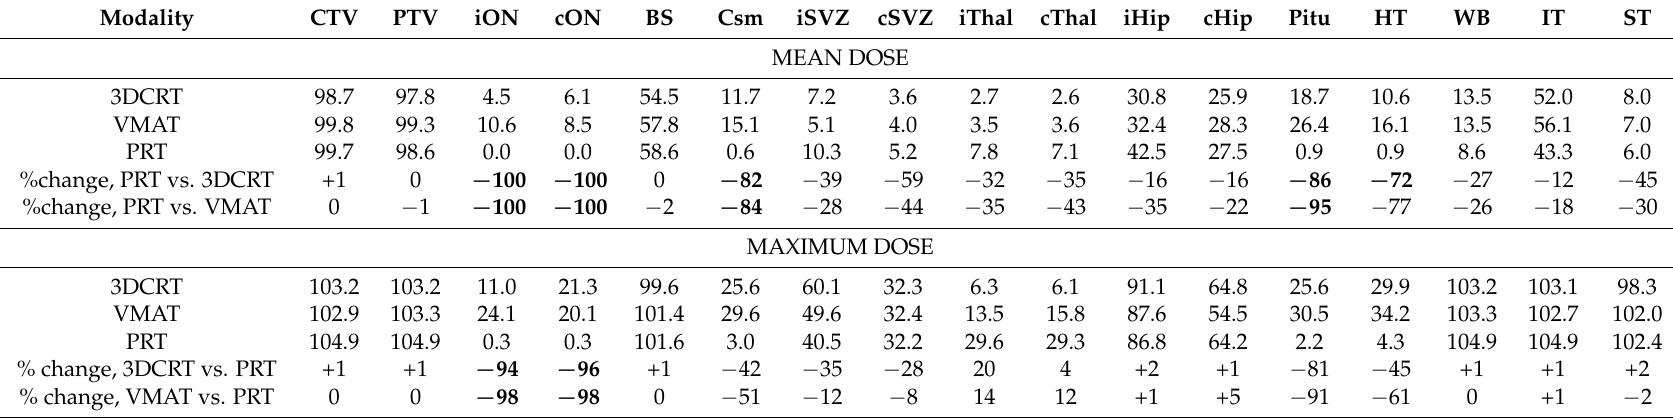
All values expressed as percentage of prescription dose. The percent change between modalities was calculated as ((PRT/other modality) × 100) − 100 for each patient; the median value for all patients is reported in the table. CTV: clinical target volume; PTV: planning target volume; i: ipsilateral; c: contralateral; ON: optic nerve; BS: brainstem; Csm: chiasm; SVZ: subventricular zone; Thal: thalamus; Hip: hippocampus; Pitu: pituitary; HT: hypothalamus; IT: infratentorial (normal) brain; ST: supratentorial (normal) brain; 3DCRT: three-dimensional conformal radiotherapy; VMAT: volumetric modulated arc therapy; PRT: proton